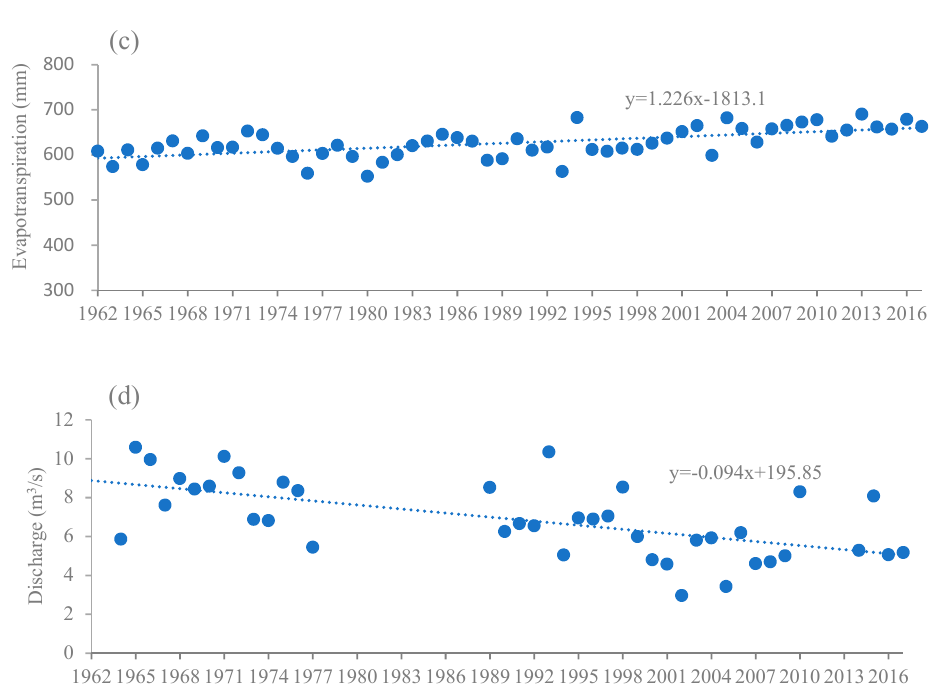
Figure 2. Annual time series of ( a ) annual precipitation; ( b ) annual temperature; ( c ) annual potential evapotranspiration; and ( d ) annual river discharge from 1962 to 2017 in the Kamo River basin.